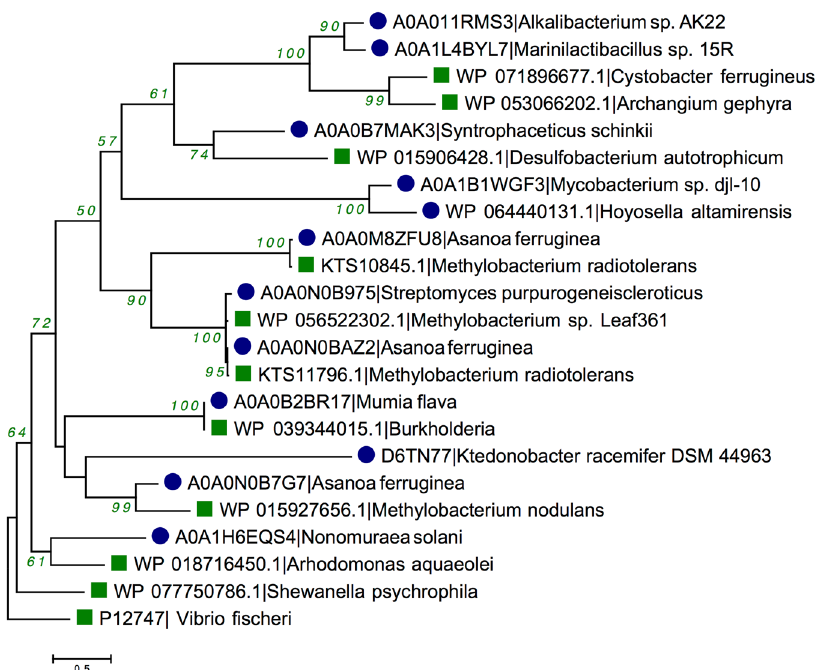
Figure 4. Phylogenetic tree reconstruction of LuxI containing protein employing Maximum Likelihood method on Gram-positive bacteria and their respective BLAST hits [ Gram-positive bacteria ( ), and Gram- negative bacteria (